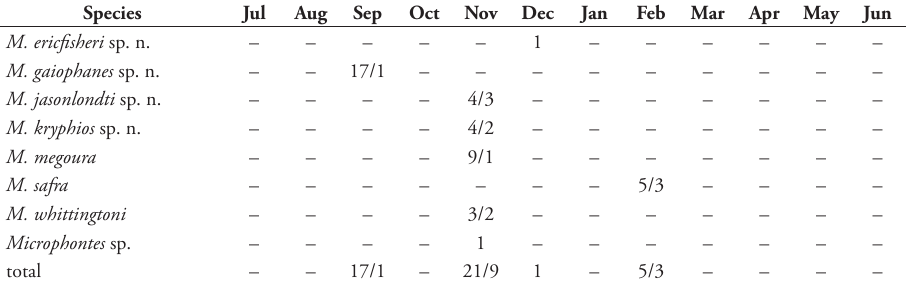
Table 2. Seasonal incidence of Microphontes species through number of specimens collected and unique collecting events in each month (data given as # specimens/# collecting events when more than one speci- men has been collected). Months abbreviated starting with July.